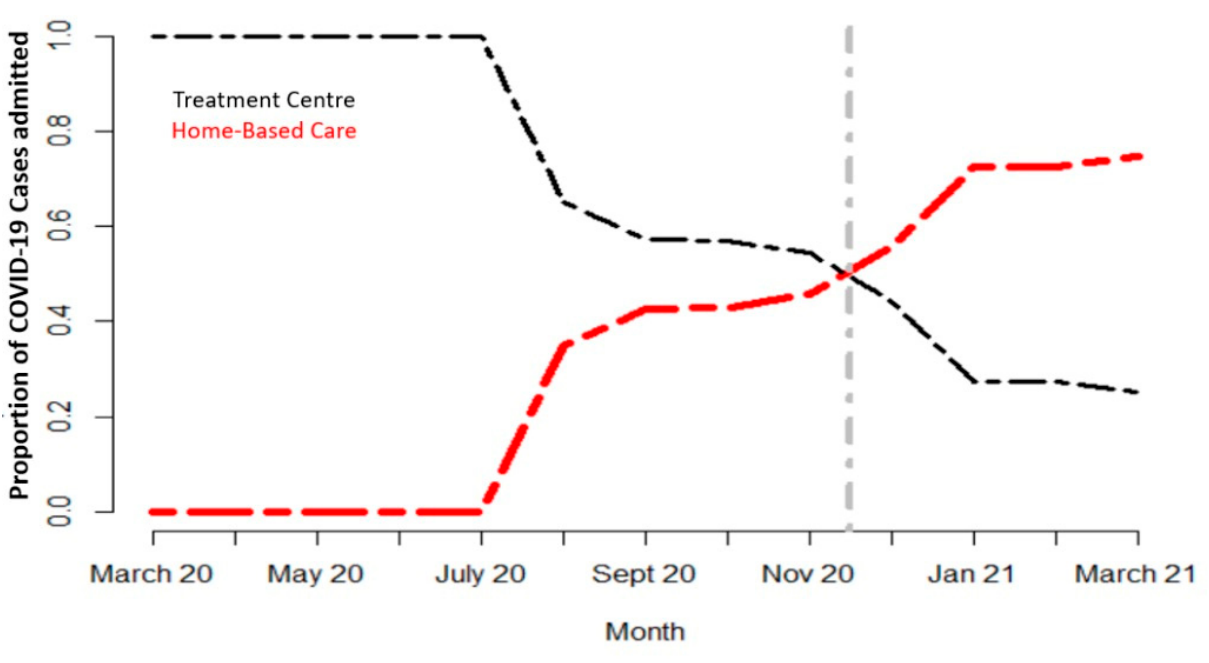
Figure 2. Trend in proportions of COVID-19 cases in HBC and treatment centers.